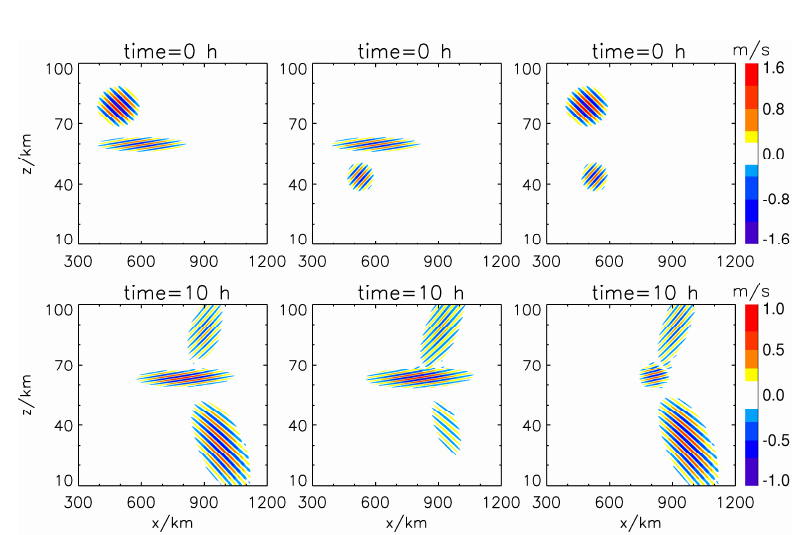
Fig. 7. Sum and difference near-resonant interactions in cases 7–9. The first, secondary and third columns represent results in cases 7–9, respectively. Figure 7. Sum and difference near-resonant interactions in cases 7-9. The first, secondary and third columns represent results in cases 7-9, respectively.